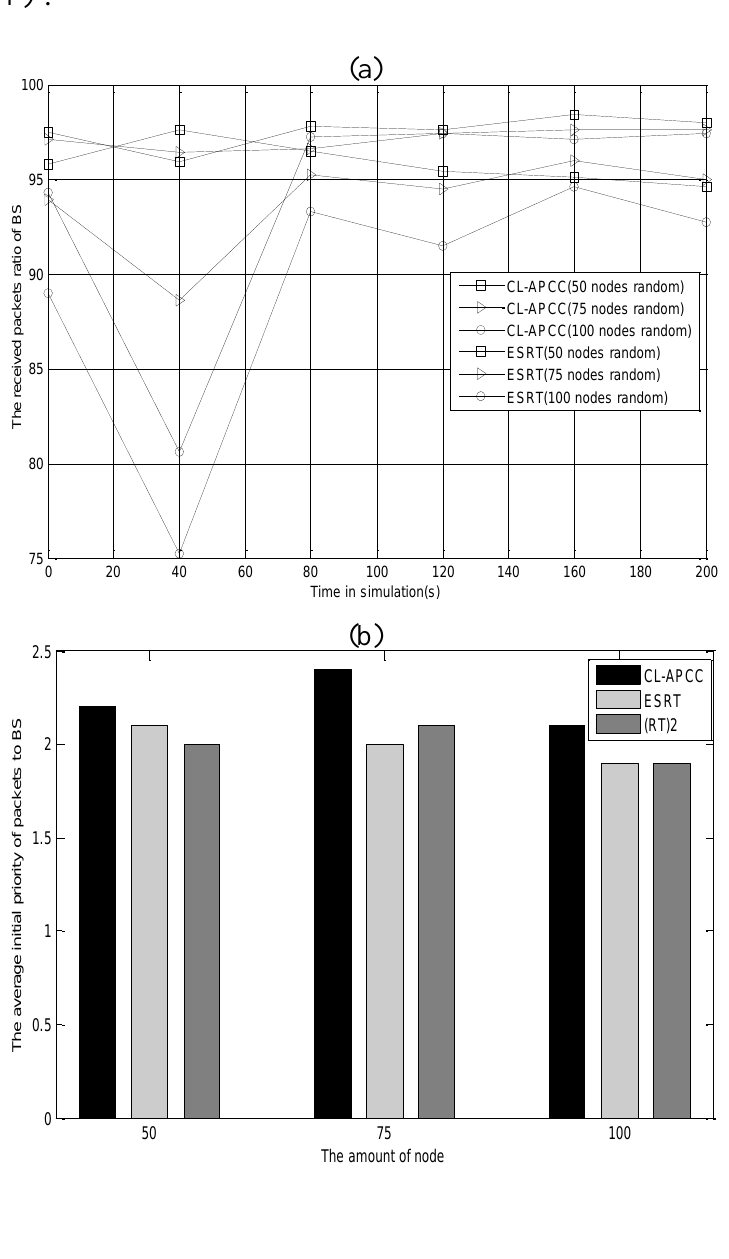
Figure 18. (a) CL-APCC in comparison with the ESRT; .(b) CL-APCC in comparison with the ESRT and (RT) 2